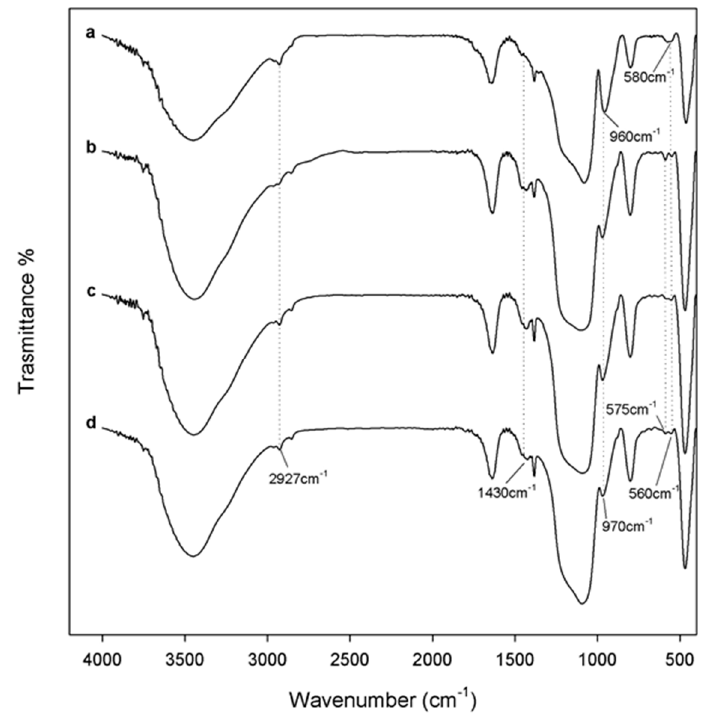
Figure 5. Representative FTIR spectra of ( a ) SiO 2 /PEG 12 wt%/ Fe(II)C 5 wt% not soaked in SBF; ( b ) SiO 2 /PEG 12 wt%/ Fe(II)C 5 wt% ; ( c ) SiO 2 /PEG 12 wt%/ Fe(II)C 10 wt% ; ( d ) SiO 2 /PEG 12 wt%/ Fe(II)C 15 wt% ; after 21 days of exposure to SBF.